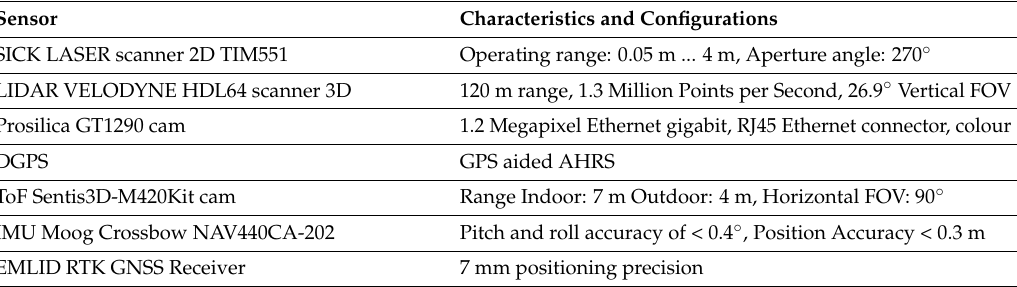
Table 4. Sensors features of the perception